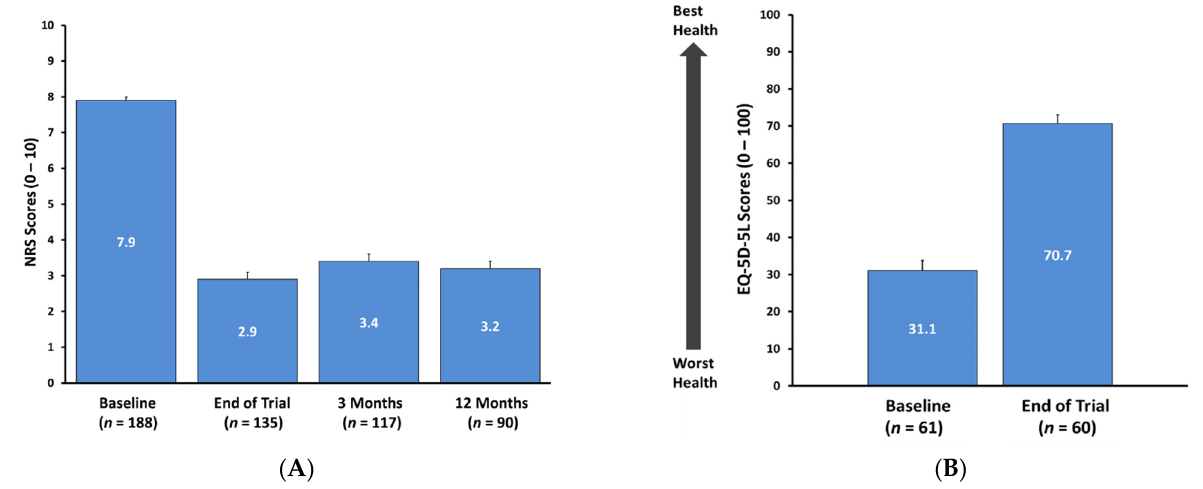
Figure 2. ( A ) Baseline, end of trial, and 3 and 12 months post-implant mean overall NRS pain scores. Error bars signify standard error (SE). p < 0.0001. ( B ) Overall quality of life, as assessed by EQ-5D-5L at Baseline and Last follow up. Error bars represent standard error (SE).